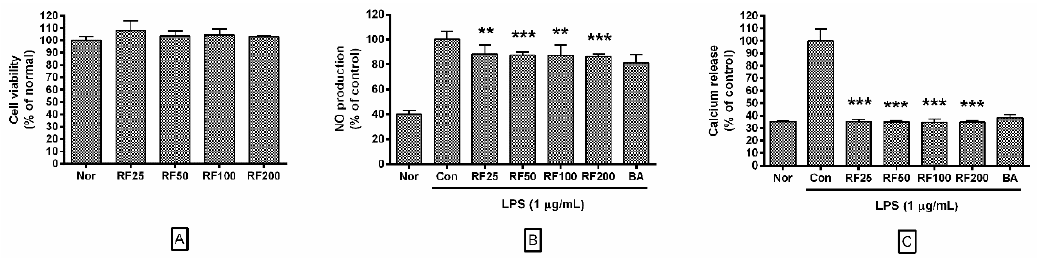
Figure 1. E ff ects of Rubi Fructus water extract (RF) on ( A ) cell viability, ( B ) nitric oxide (NO) production, and ( C ) intracellular calcium release. Cells were treated with RF and LPS for 24 h ( A , B ) or 18 h ( C ). “Nor” indicates the group treated with media only. “Con” indicates the group treated with 1 µ g / mL of lipopolysaccharide (LPS) alone. RF25, RF50, RF100, and RF200 indicate 25, 50, 100, and 200 µ g / mL of RF, respectively. “BA” indicates treatment with baicalein (25 µ M). Values represent means ± SD of three independent experiments ( n = 3). Statistical significance was calculated by one-way ANOVA and a Tukey multiple comparison test. ** p < 0.01 vs. Con; *** p < 0.001 vs. Con .